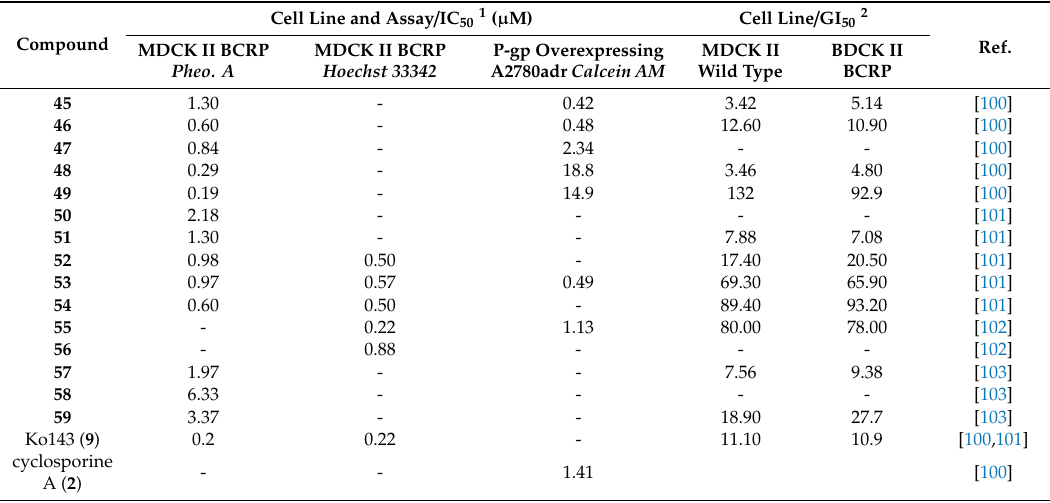
Table 3. Inhibitory activities of compounds 45 – 59 against BCRP and P-gp as determined in the pheophorbide A and calcein AM